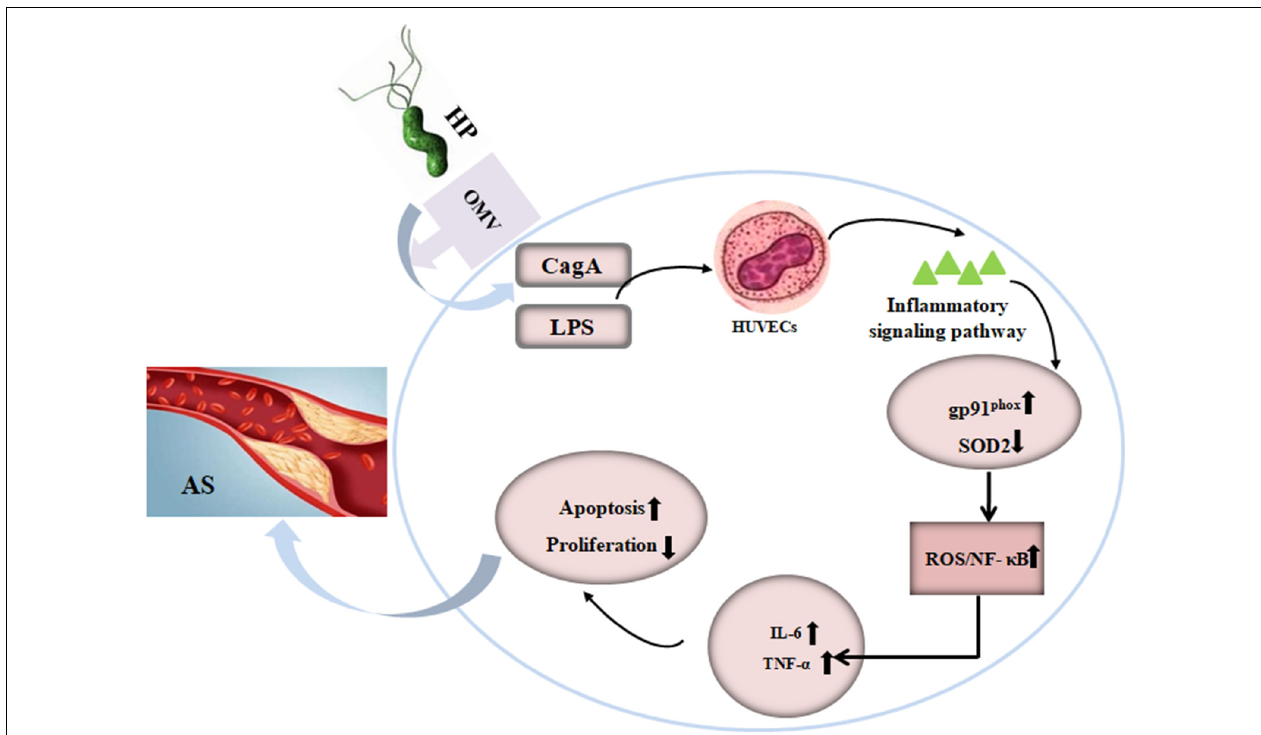
FIGURE 6 | Schematic representation of the effect of OMVs from H. pylori on atherosclerosis plaque formation in ApoE − / − mice. AS, atherosclerosis; CagA, cytotoxin-associated gene A; HP, Helicobacter pylori ; HUVECs, human umbilical vein endothelial cells; IL-6, interleukin-6; LPS, lipopolysaccharide; NK- κ B, nuclear factor- κ B; OMVs, outer membrane vesicles; SOD2, superoxide dismutase 2; TNF- α , tumor necrosis factor- α .